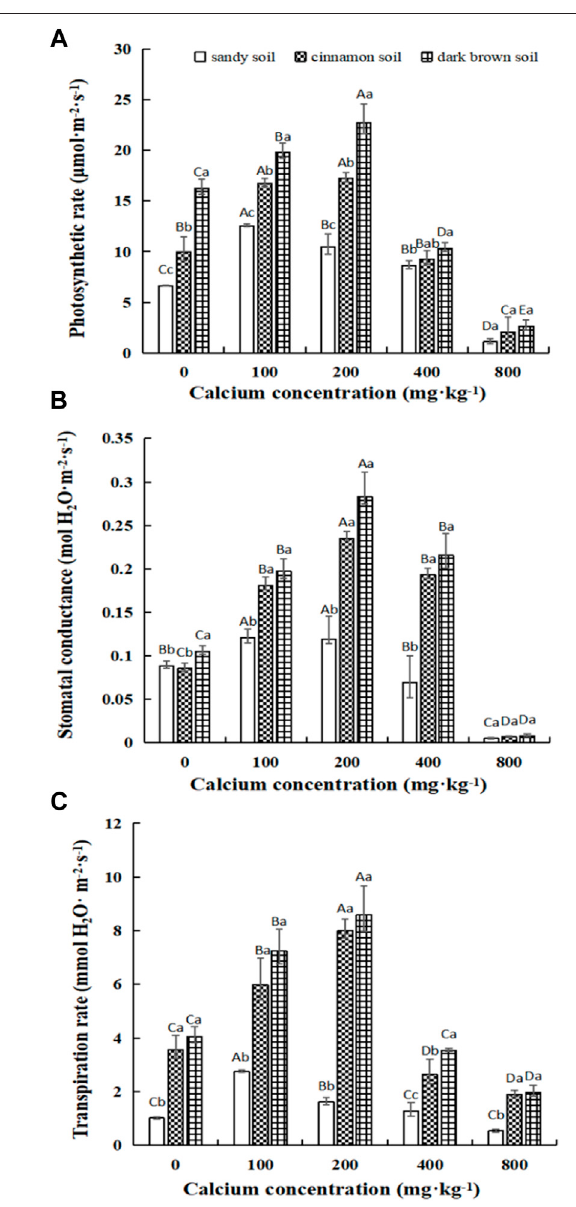
FIGURE 3 | Effects of exogenous calcium on gas exchange rates of Mongolian pine seedlingsin different soil types. Note: Each column shows the average value ± SE, n = 3. Different capital letters indicate the difference between different calcium concentrations under the same soil type, and different lowercase letters indicate the difference between different soil types under the same calcium concentration ( p < 0.05).